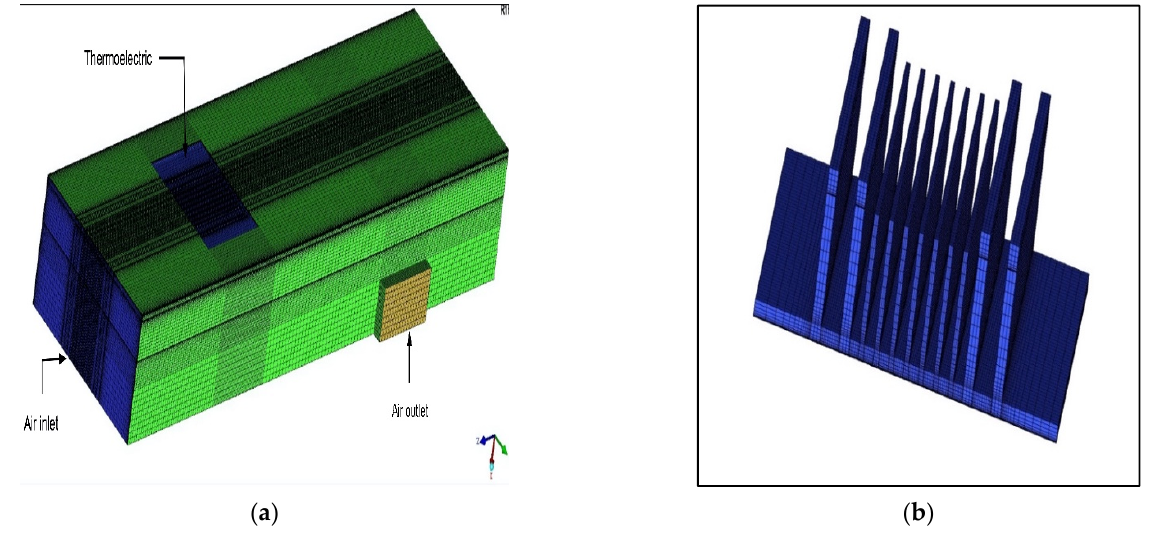
Figure 4. CAD model of the tested prototype.